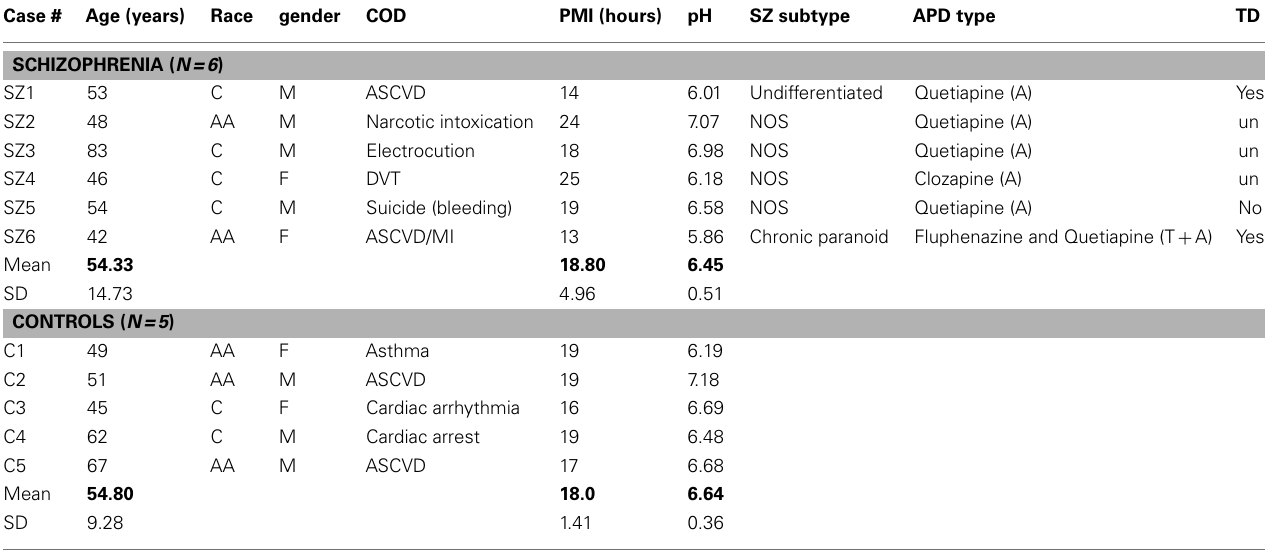
Table 1 | Pilot study: demographic table and clinical data in schizophrenia and